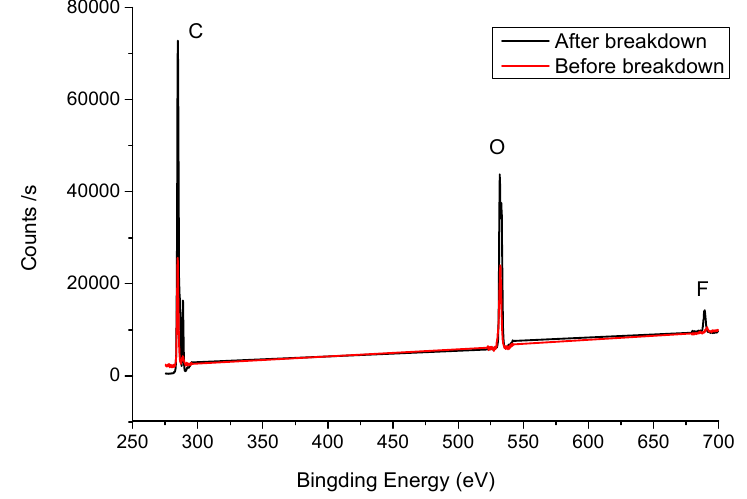
Figure 3. Detection results of the surface elements of the sphere electrode.